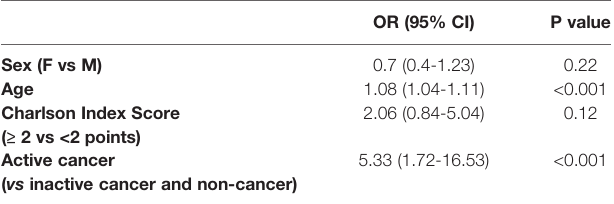
TABLE 4 | Multivariate analysis (logistic regression model) identifying factors independently associated with a severe presentation of